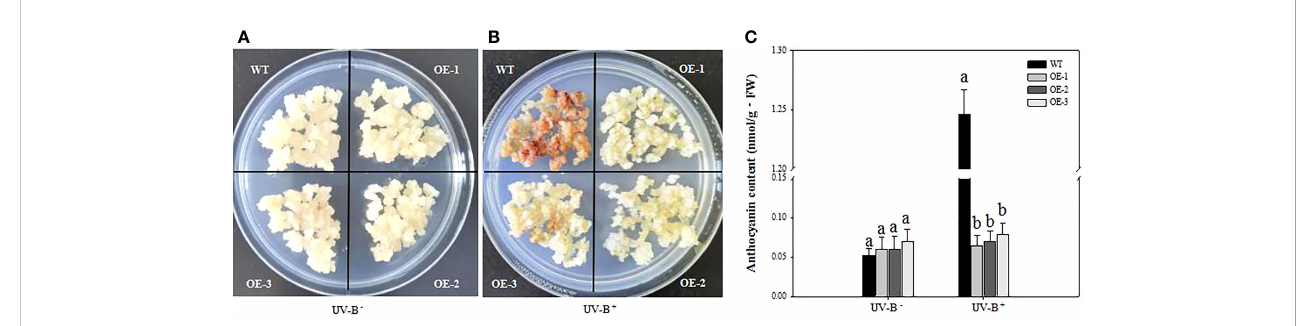
FIGURE 3 Anthocyanin contents of wild-type (WT) and VcMYB4a- overexpressing (OE-1, OE-2, and OE-3) blueberry calli after 4 days of exposure to UV-B radiation. Untreated calli (A) and calli after 4 days of UV-B treatment are shown (B) . (C) Anthocyanin contents of WT and VcMYB4a- overexpressing calli treated or not with UV-B radiation for 4 days. Error bars indicate SD of the mean of three independent biological replicates, each with three technical replicates; different letters indicate signi fi cant differences ( p < 0.05) among samples by Tukey ’ s